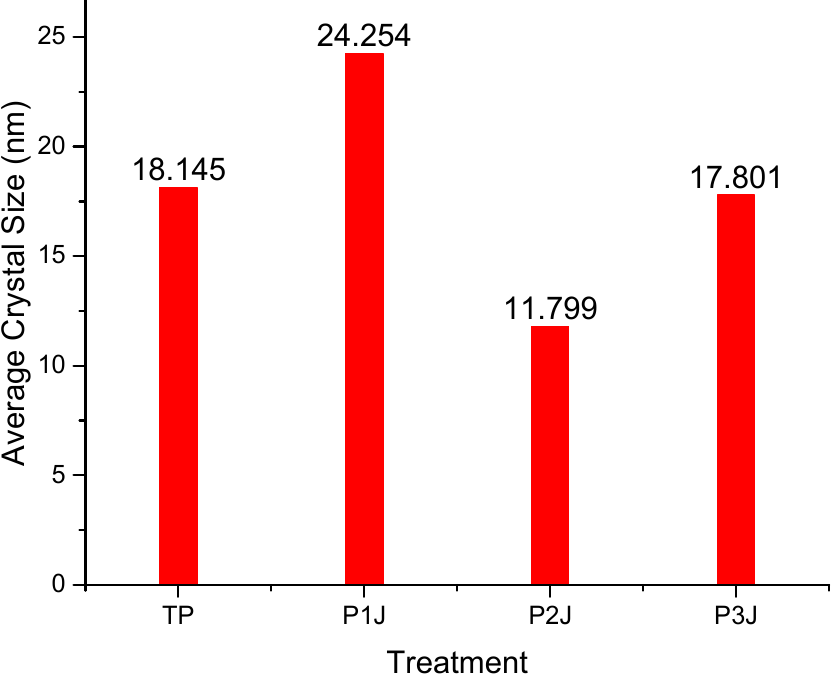
Figure 8. Average Crystal Size of BSFs (TP, P1J, P2J, and P3J). fiber when compared to the crystal size of TP fiber; the largest crystal size occurred in